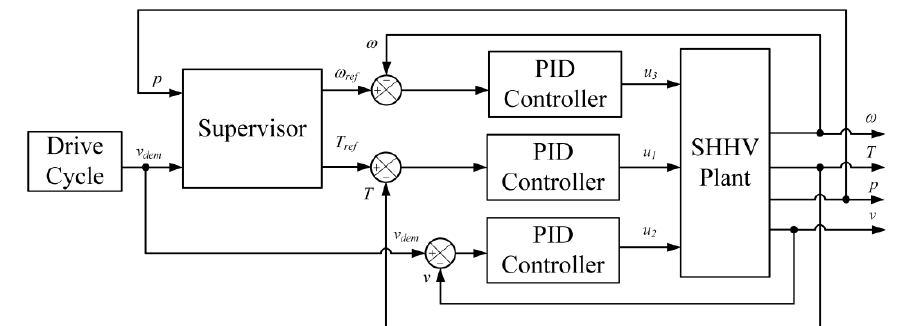
Figure 11. Schematic of the PID-based control